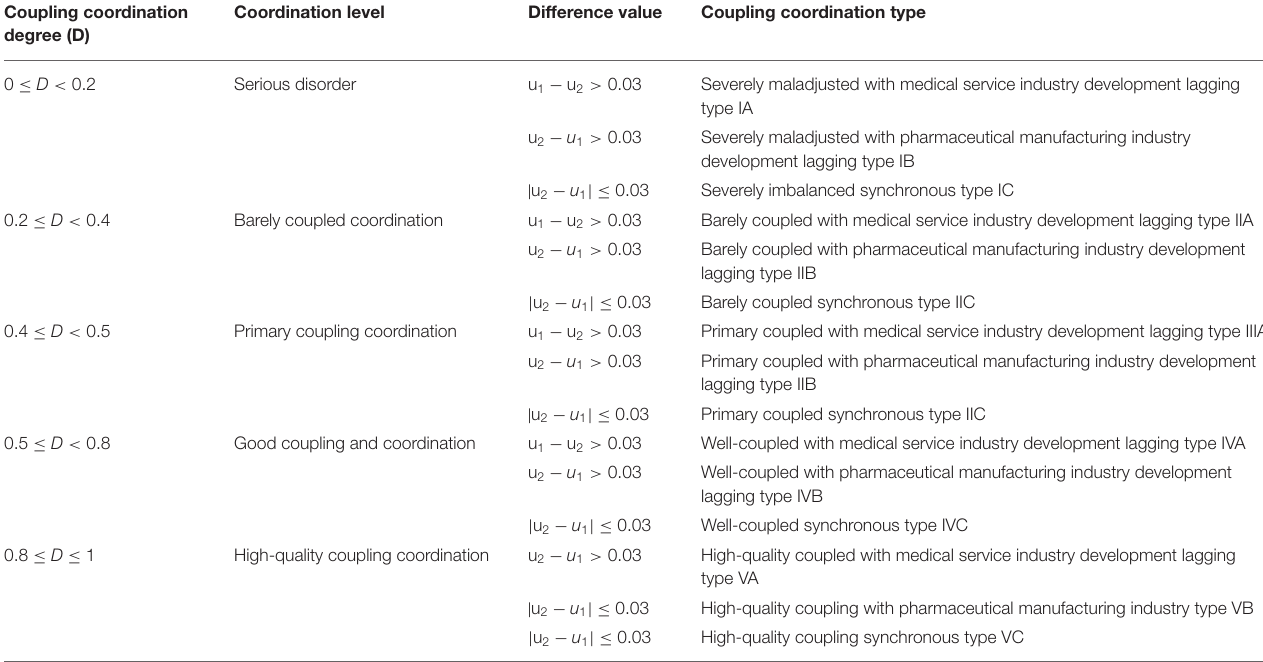
TABLE 2 | Classification of coupling coordination degree.